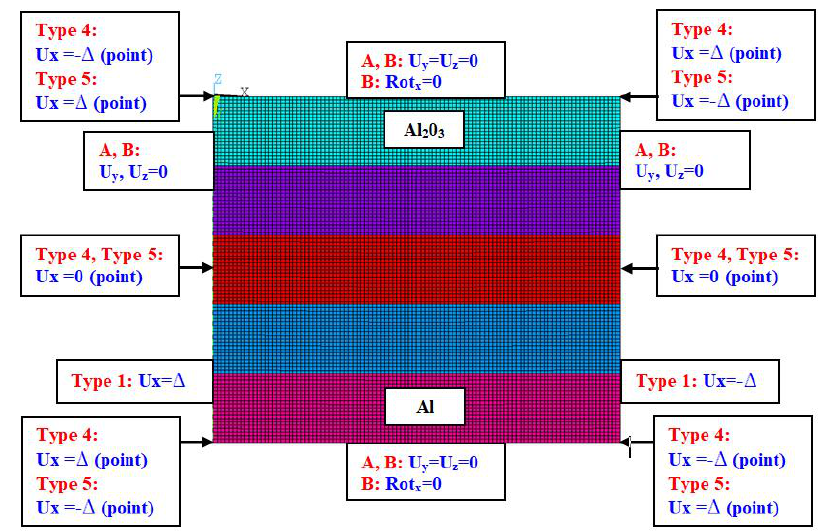
Figure 2. Numerical model of the rectangular plate with boundary conditions. Table 1. Mechanical properties for detailed strips.